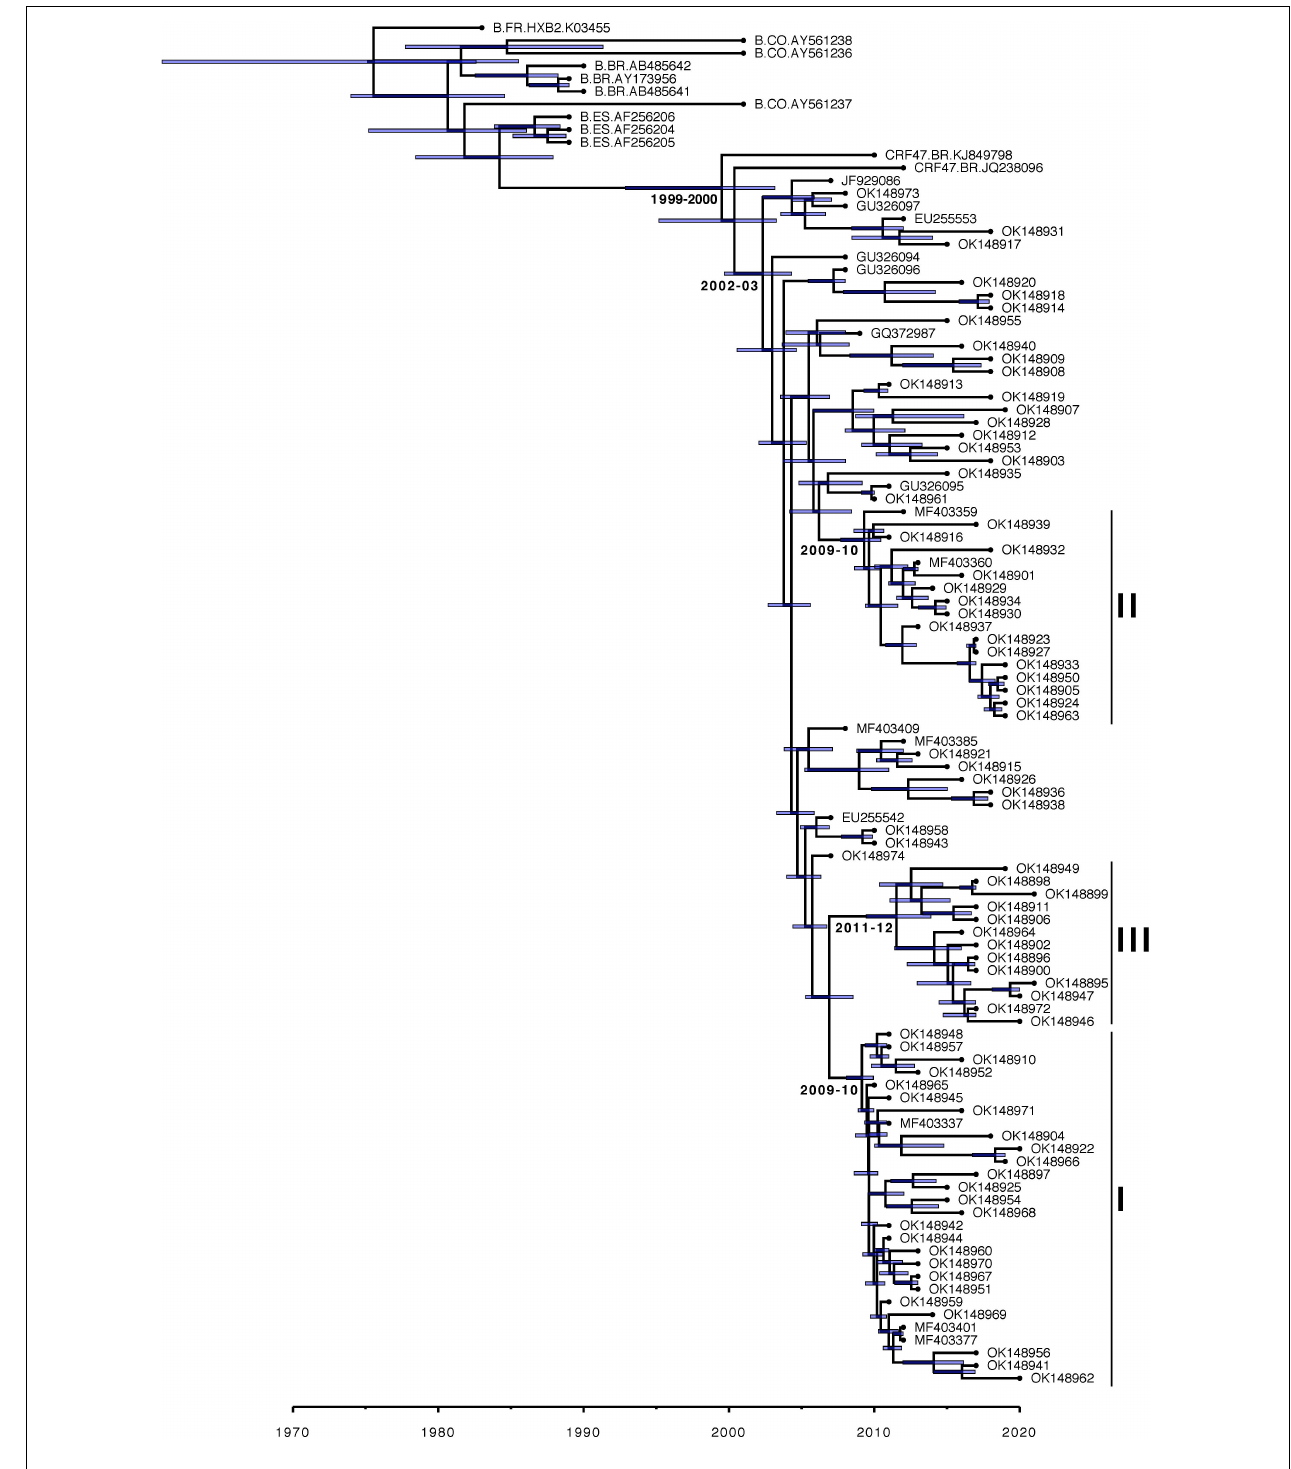
FIGURE 5 | Maximum clade credibility Bayesian (BEAST) chronogram estimate of CRF47_BF sequences from Spain and other CRF47_BF sequences from GenBank, as well as a few additional subtype B sequences from Spain, Brazil, and Colombia plus HXB2, all to serve as an outgroup to the CRF47_BF sequences. Clusters associated with the Spanish regions of Basque Country (cluster I), Navarre (cluster II), and Aragon (cluster III) are indicated. Estimated years of emergence of CRF47_BF in Brazil, of its introduction in Spain, and of emergence of the Spanish clusters are indicated besides the corresponding nodes. A total of 95% highest posterior density (HPD) intervals (blue bars) are shown for all time